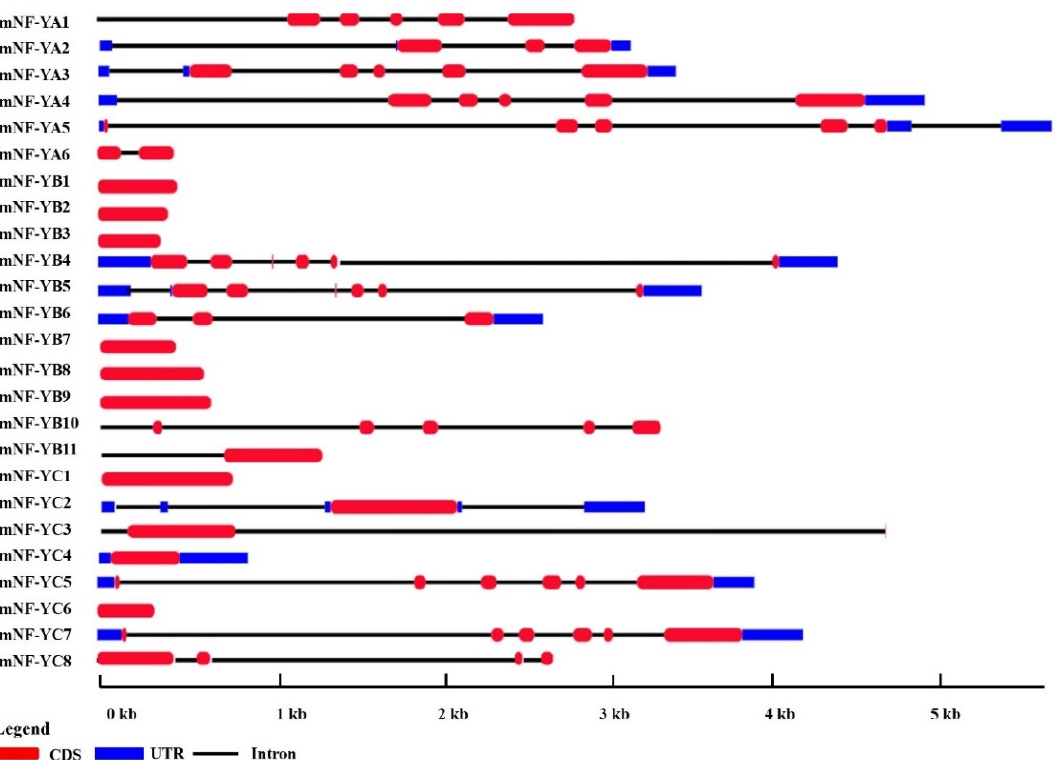
Figure 1. Gene structure of CmNF-Y genes. The red boxes and black lines indicate exons and introns, respectively. The blue boxes indicate untranslated regions. Their lengths can be estimated by the scale bar at the bo tt om.